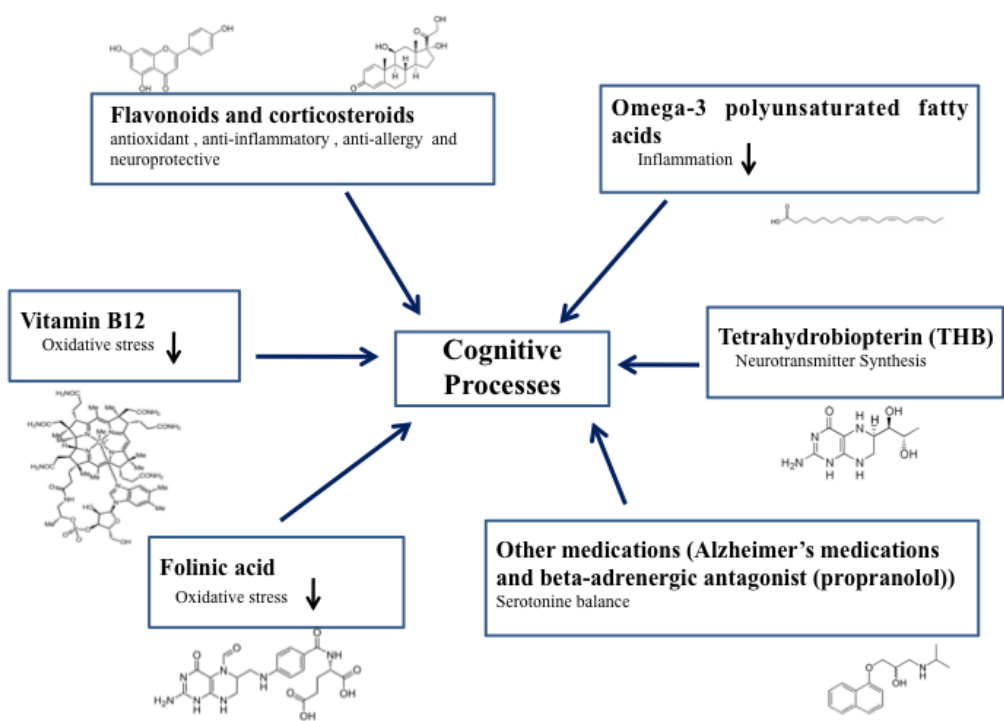
Figure 1. Key elements of cognitive process regulation through substances discussed in the manuscript and their chemical structures.